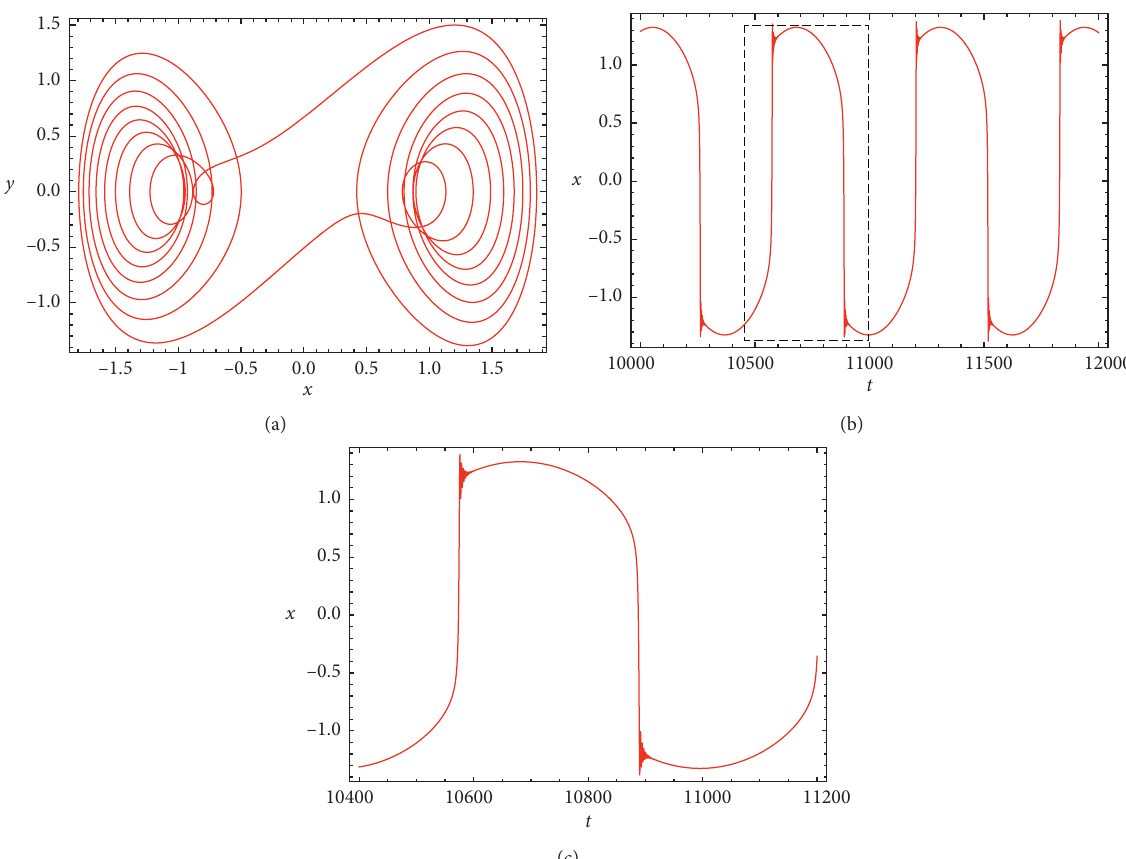
Figure 1: Phase portraits (a) and time series (b, c) of fast-slow system (2) for a � b � α � 1 , ω